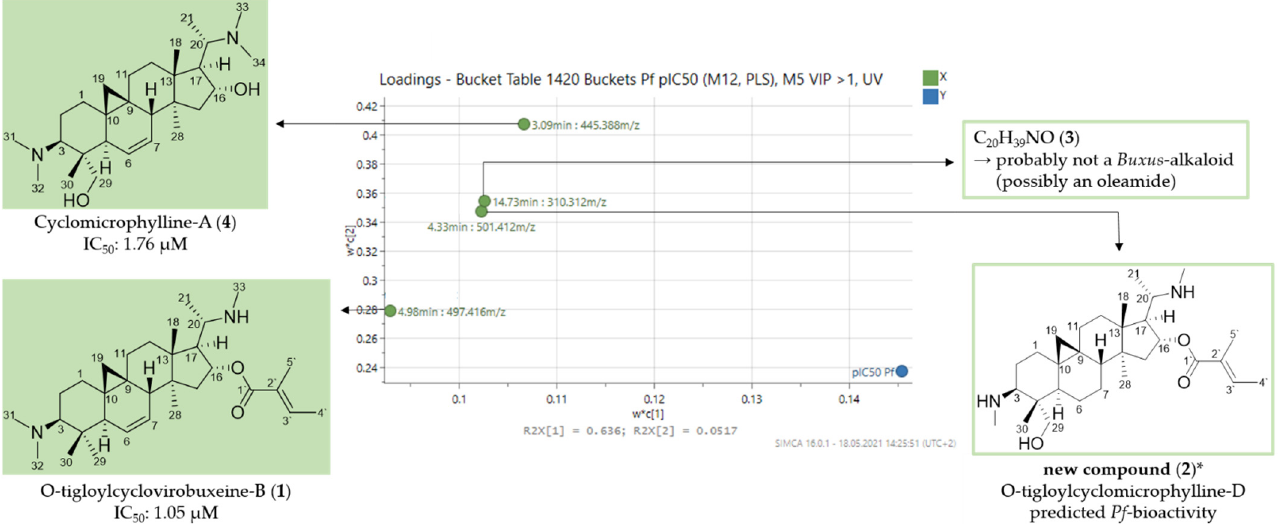
Figure 2. Expansion of region of the loadings plot (Figure 1) with the buckets that, according to the PLS model, have a high impact on the antiplasmodial activity of B . sempervirens L. * Structural assignment based only on mass spectral data; stereochemistry tentatively assumed in analogy with known compounds [7]. Table 3. LC/MS-characteristics of the compounds with predicted antiplasmodial activity (compare Figure 2). Bucket